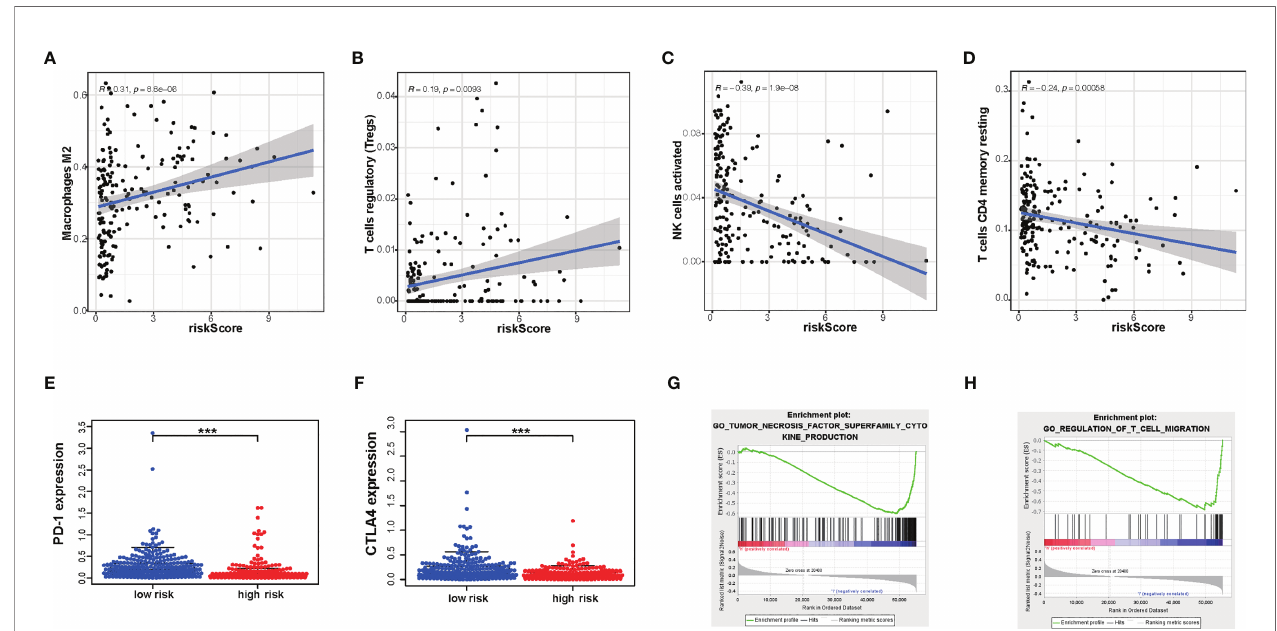
FIGURE 7 | The differences in immunocyte in fi ltration degree and enrichment plots of immune-related gene sets from Gene Set Enrichment Analysis (GSEA) between the high- and low-risk TCGA cohorts. (A – D) The correlation with immunocyte in fi ltration was performed by using Pearson correlation analysis. M2; Tregs; NK cells; CD4+T cells. (E , F) Correlation with immune-checkpoint expression. PD-1; CTLA4. (G , H) GSEA analysis revealing immune-related biological processes correlated with the signature. ***P <